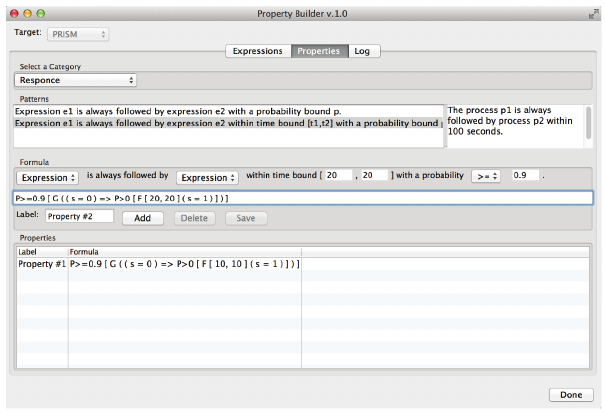
Figure 7: Property Generator